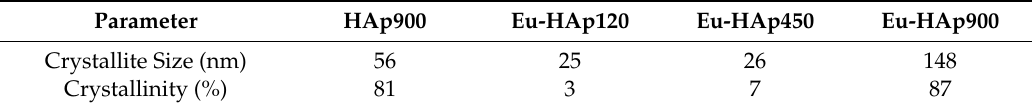
Table 3. Crystallite size (nm) and crystallinity (%) for HAp